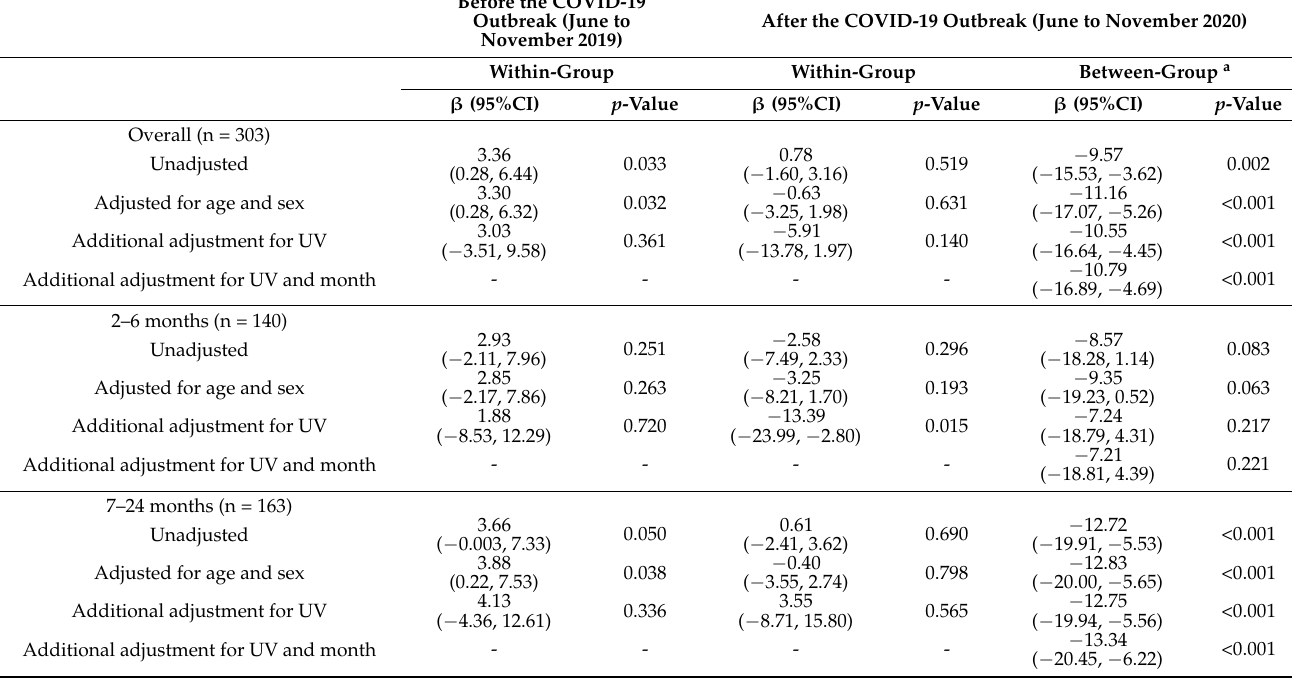
Table 2. Effect of time on serum 25(OH)D level in infants and toddlers in Hong Kong before and after the COVID-19 outbreak.